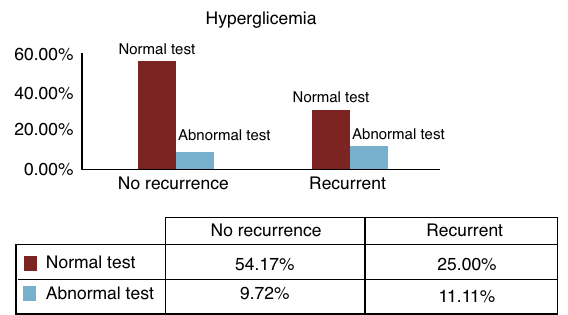
Distribution of patients with BPPV recurrence, regarding tests with hyperinsulinemia.